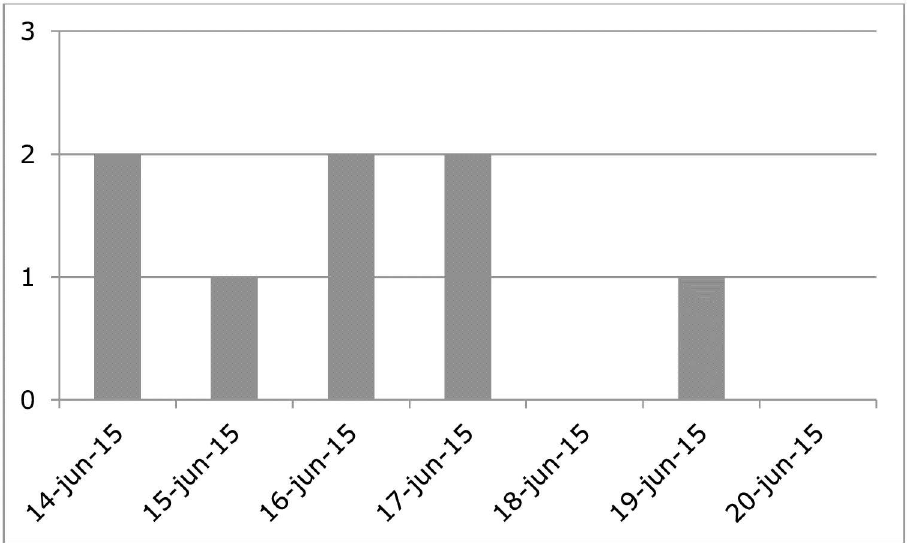
Fig 1. Epicurve Singel Swim Utrecht, 14 June 2015. The numberof cases by date of onset of AGI following the event.